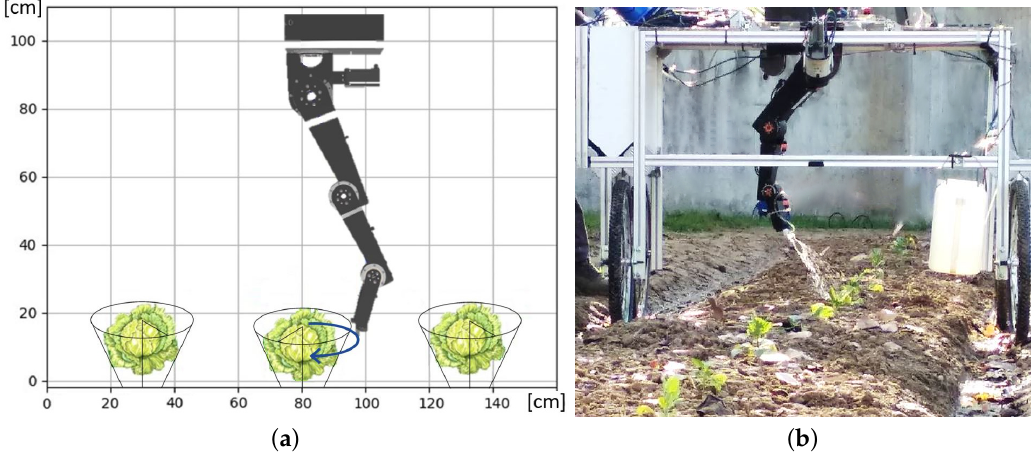
Figure 4. Positioning strategy for fertiliser application based on geometrical parameters. ( a ) Geometric description of robot positioning and movement, ( b ) fertiliser application by robotic arm. Source: